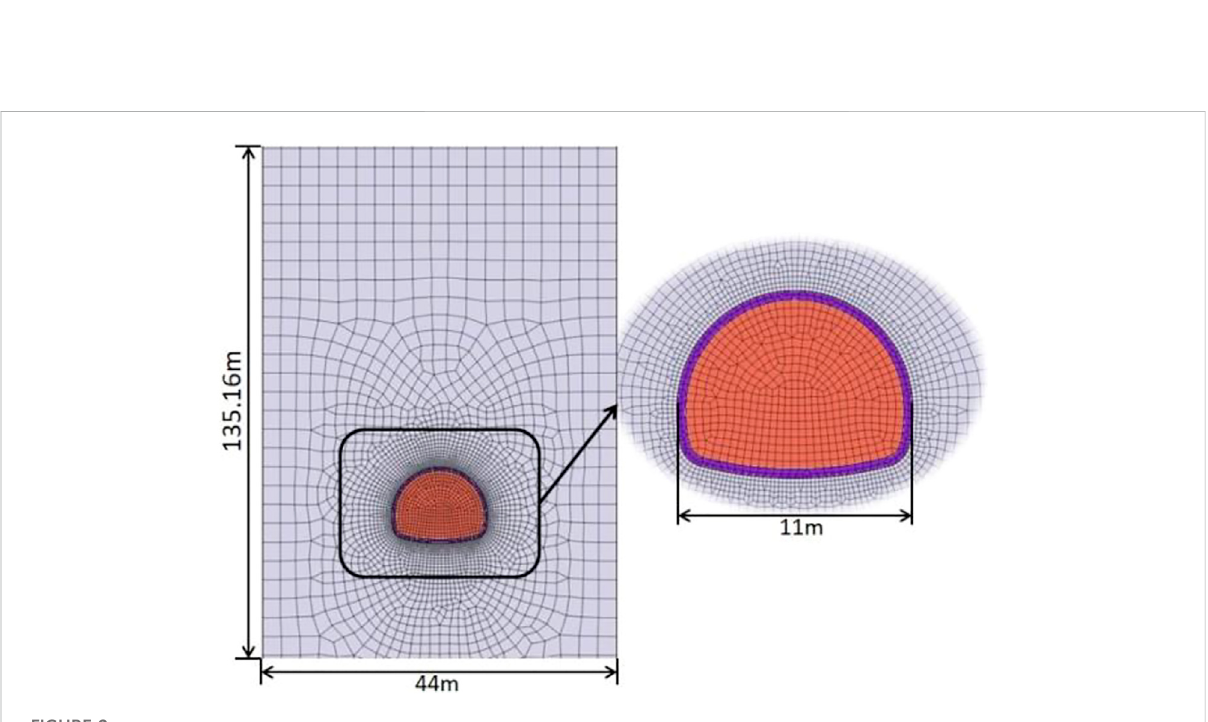
FIGURE 2 Numerical calculation